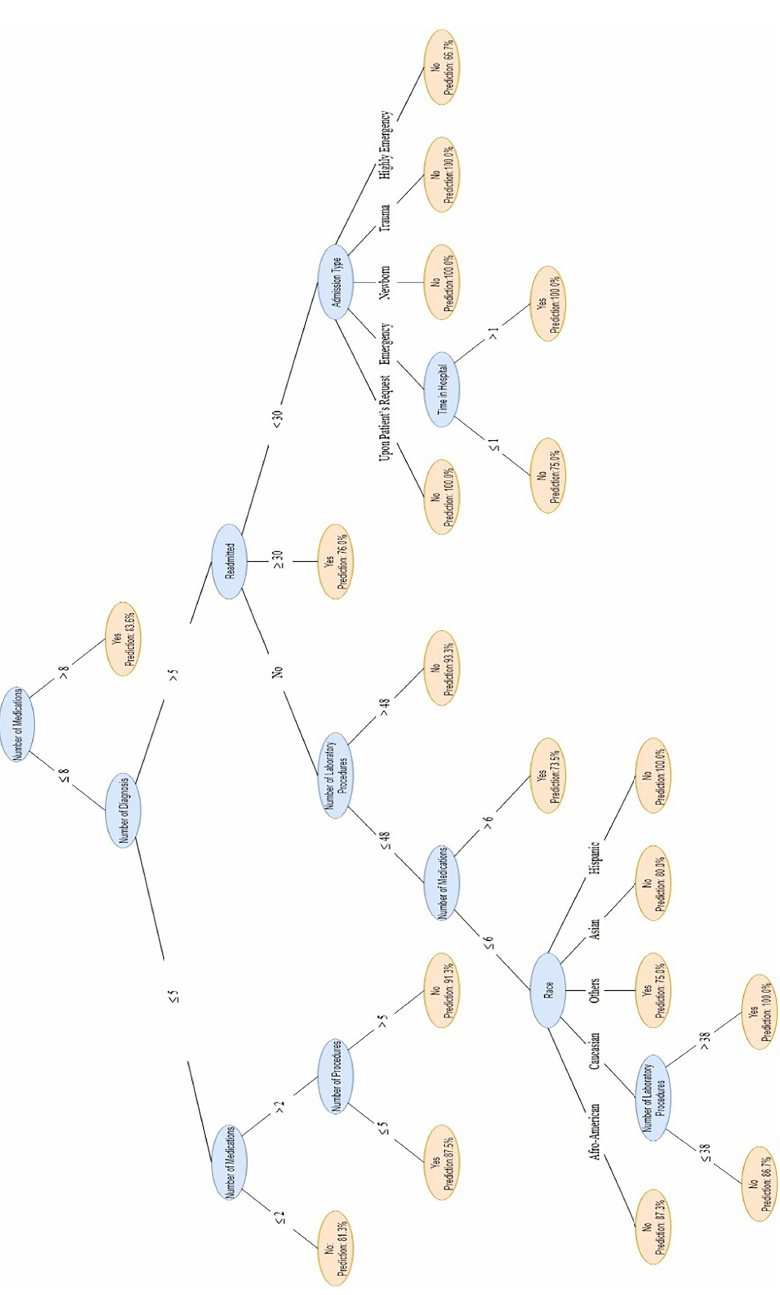
Figure 3. One of the tree diagrams of the random forest